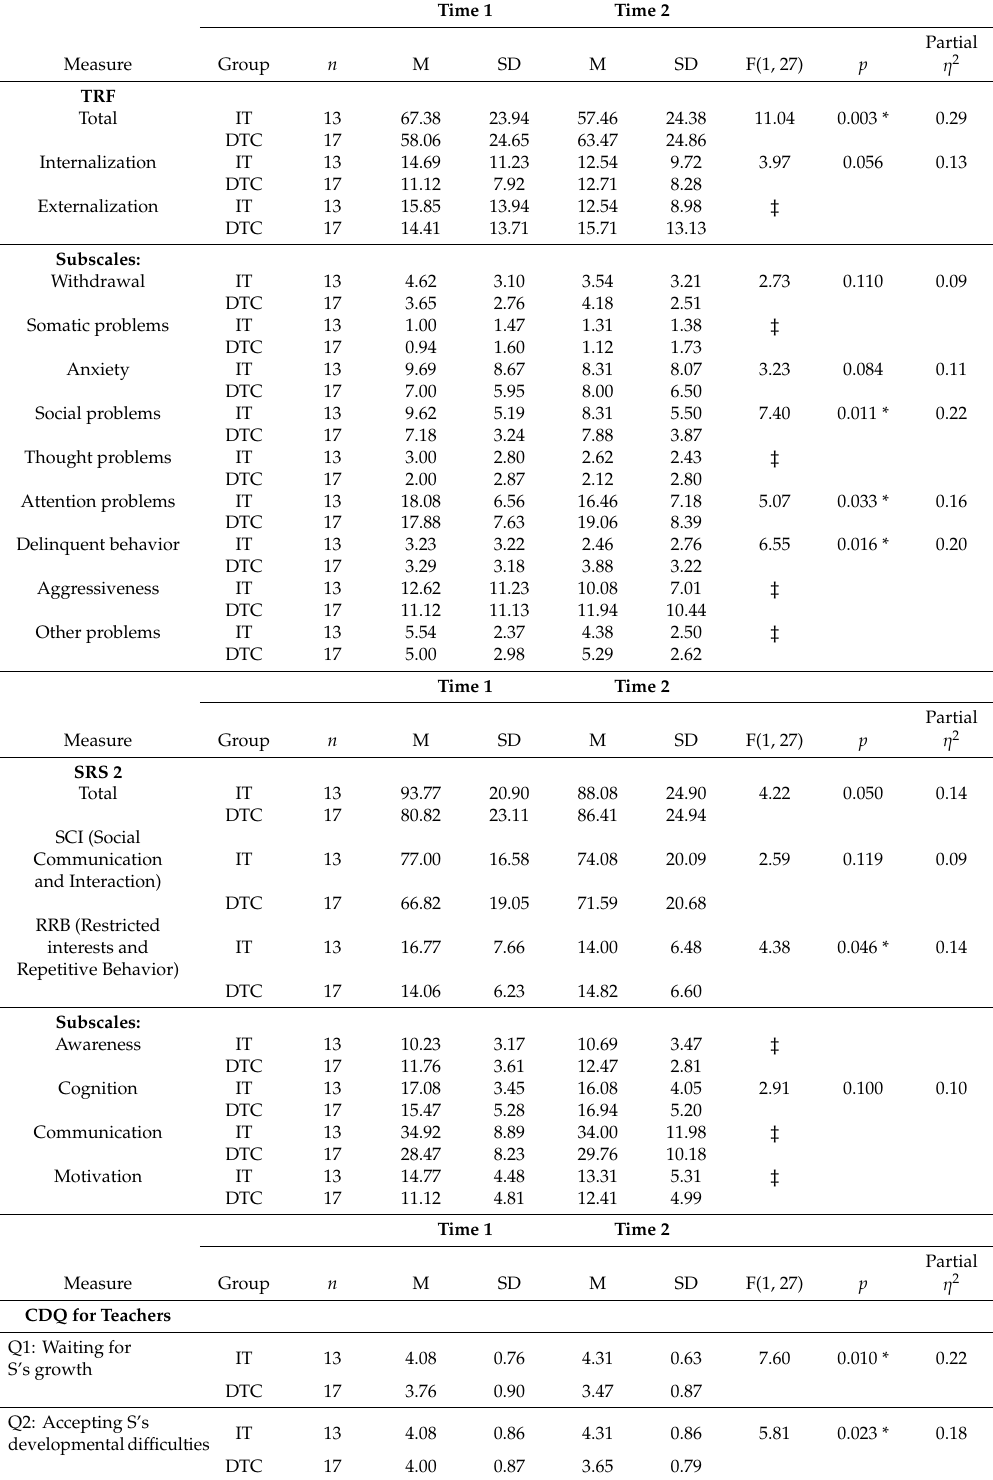
Table 5. Descriptive statistics for student and teacher outcome measures and results of